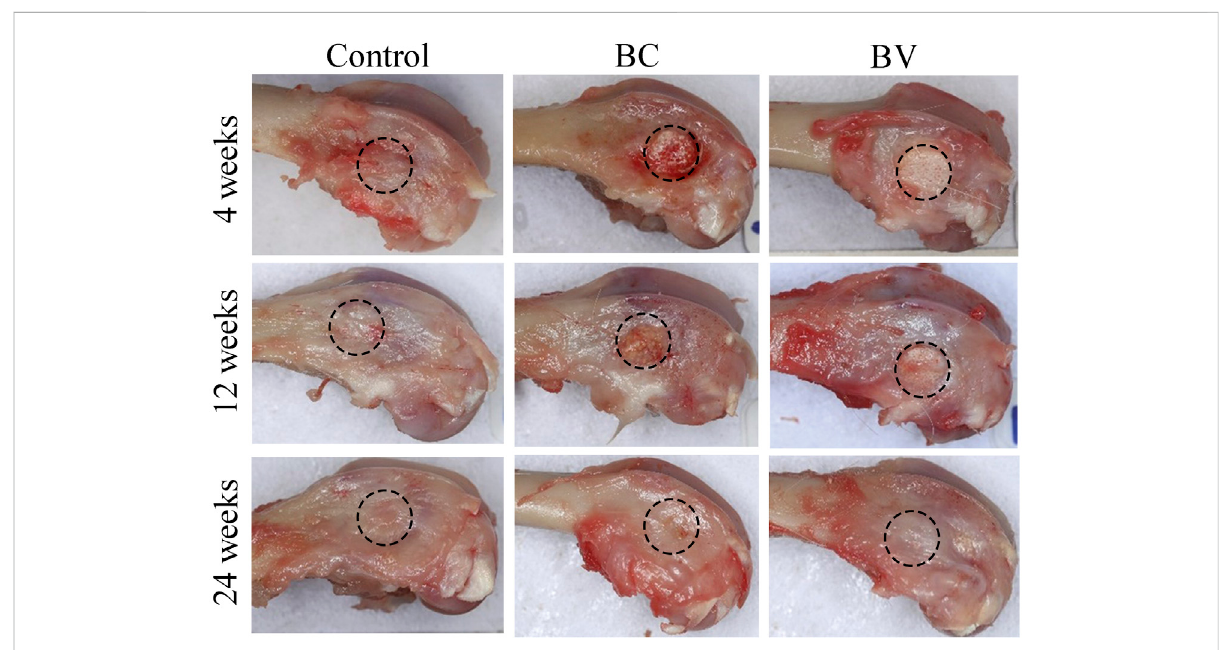
FIGURE 1 General grossobservation ofrabbitfemurcondyle.Theimplantationsitewashealed,andnoabnormalitieswereobservedinthecontrol,BC,or BVfemoralcondylesat4,12,and24 weeksafterimplantation.Theblackdashedcircleshowstheimplantsite.(BC,Bicera ™ ;BV,Vancomycin-loaded Bicera ™